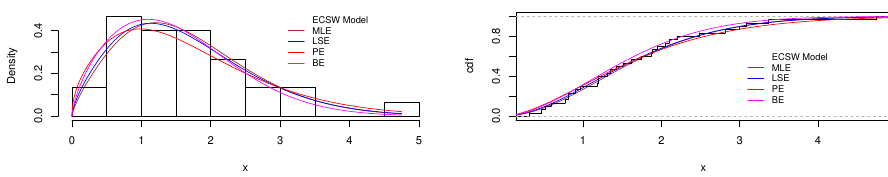
Figure 8. Plots of the estimated pdfs and histogram, empirical cdf and estimated cdfs for the precipitation data.